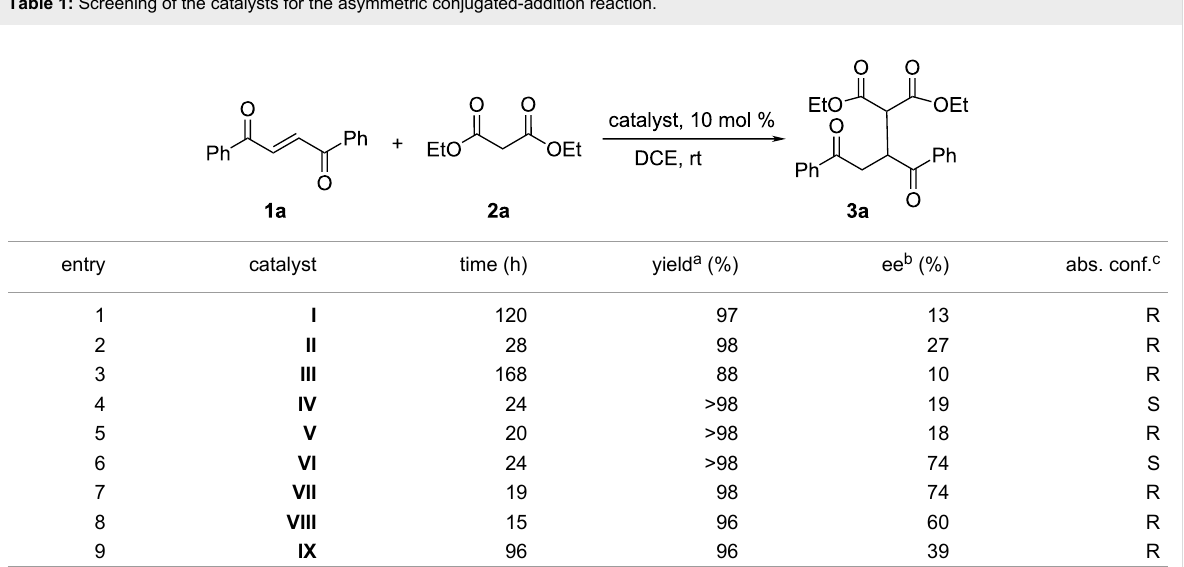
Table 1: Screening of the catalysts for the asymmetric conjugated-addition